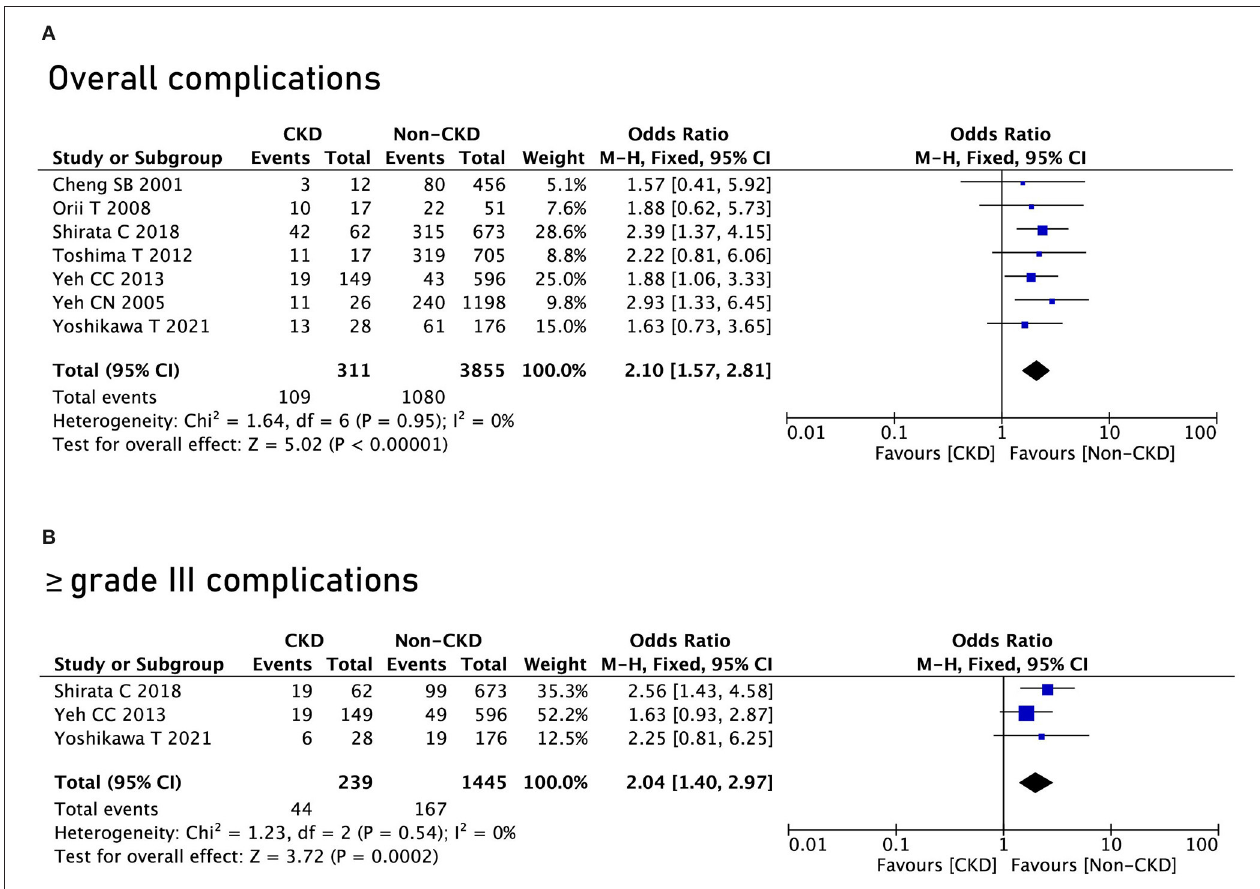
FIGURE 2 | Complications between the chronic kidney disease (CKD) group and the non-CKD group. (A) Overall complications; (B) ≥ grade III complications.